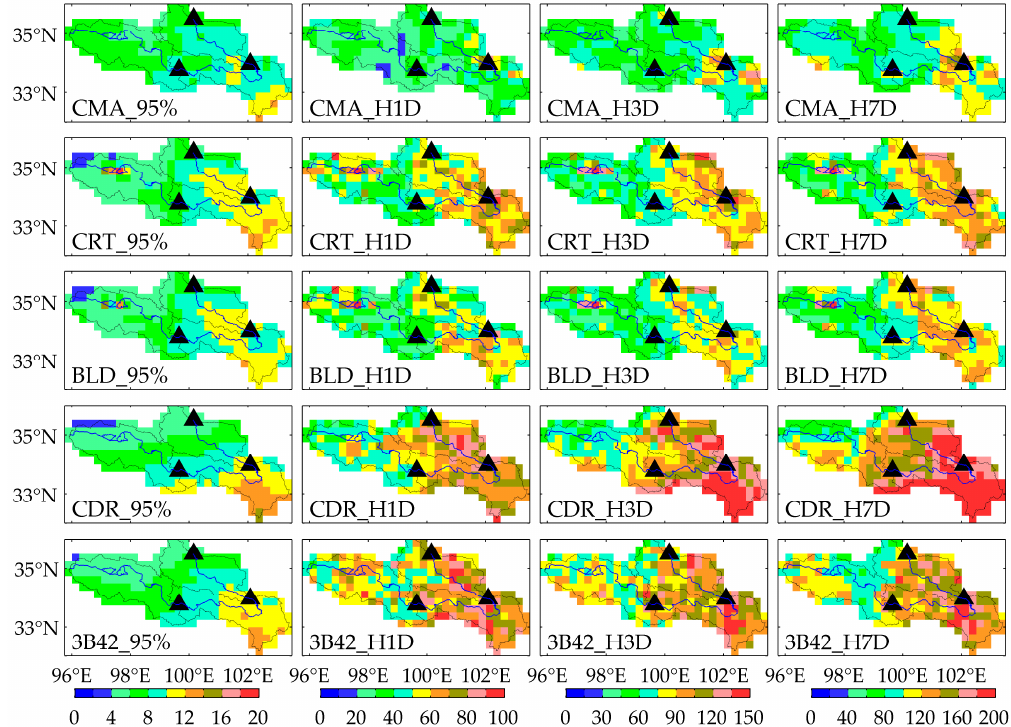
Figure 5. Spatial distribution of the extreme value of precipitation (95%, H1D, H3D and H7D) in UYRB for the total period from 2001 to 2012.